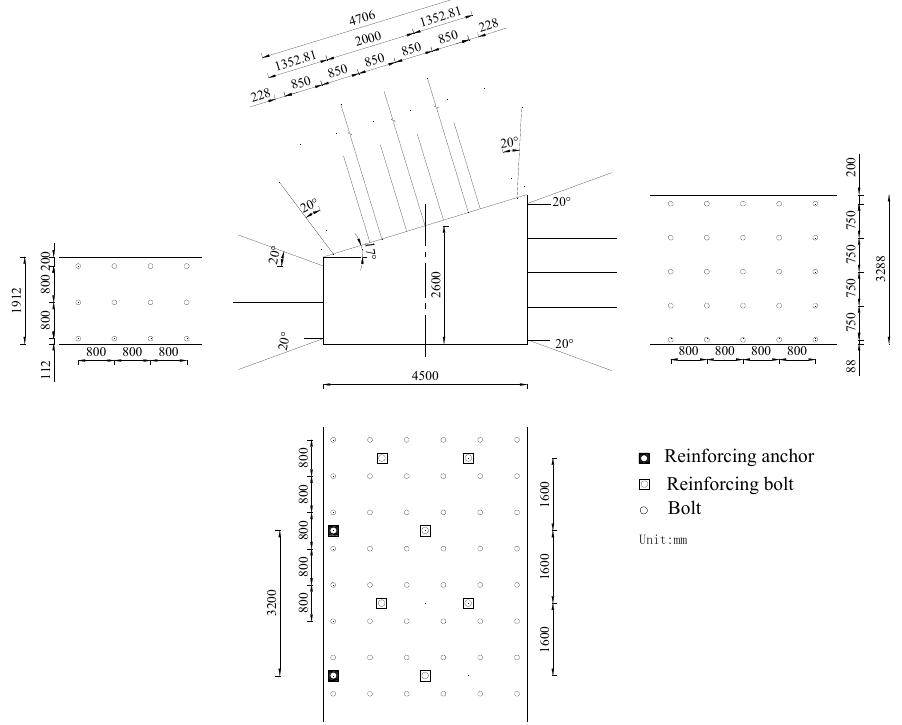
Figure 9. The support arrangement for the roadway in the 72207 working face.